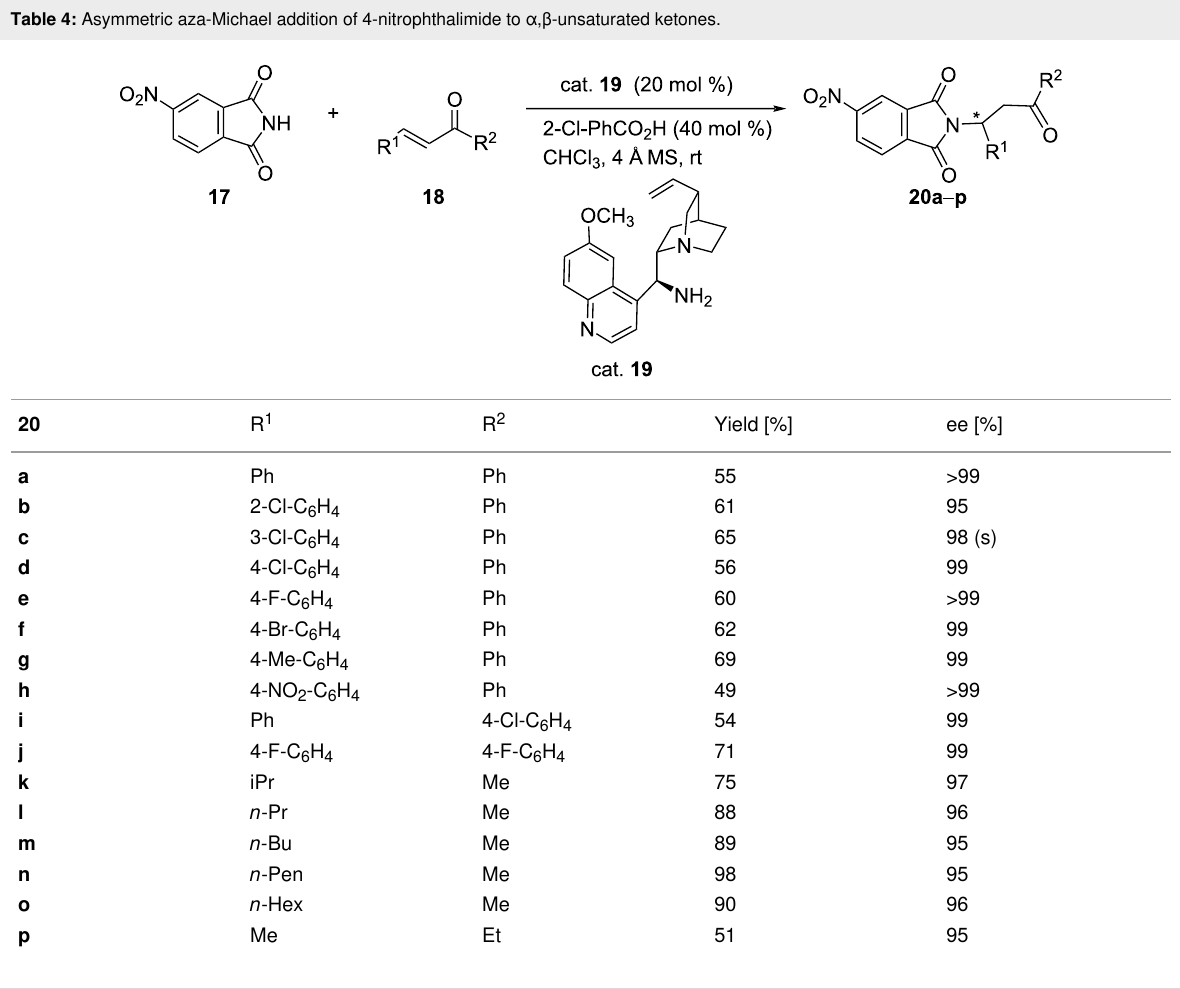
Table 4: Asymmetric aza-Michael addition of 4-nitrophthalimide to α , β -unsaturated